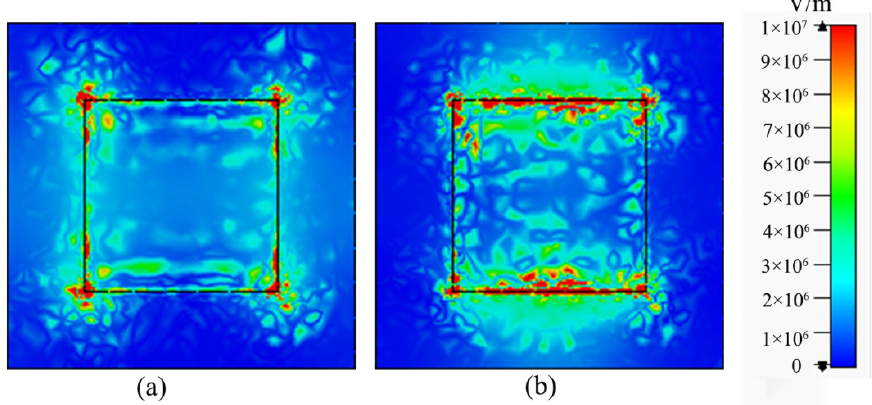
Figure 4. Electric field distributions of the graphene composite layer at resonance frequencies of ( a ) 2.995THz and ( b ) 4.808THz.